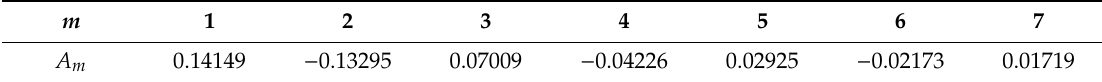
Table 4. The values of coe ffi cients A m and B m of the solution u ( 7 ) ( x , t ) (see Example 2).